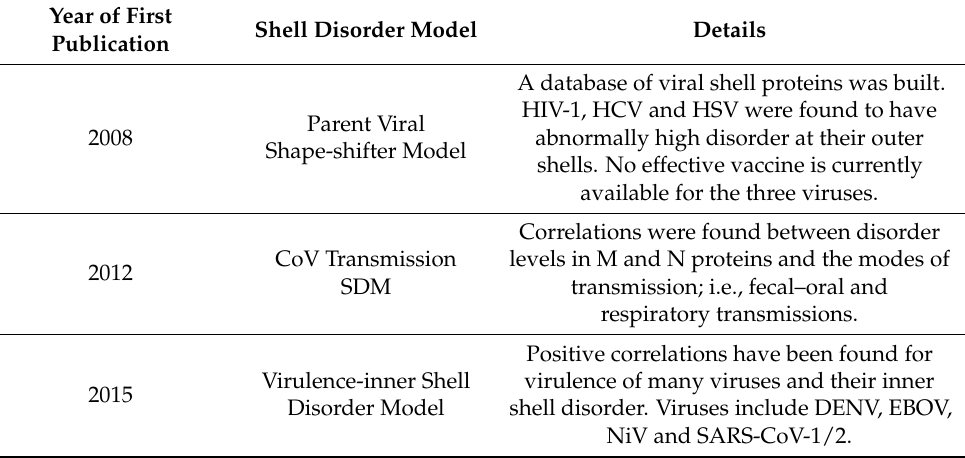
Table 1. The Shell Disorder Models (SDMs). There are three closely related models based on the principles of protein intrinsic disorder. Levels of disorder are measured at each shell of the